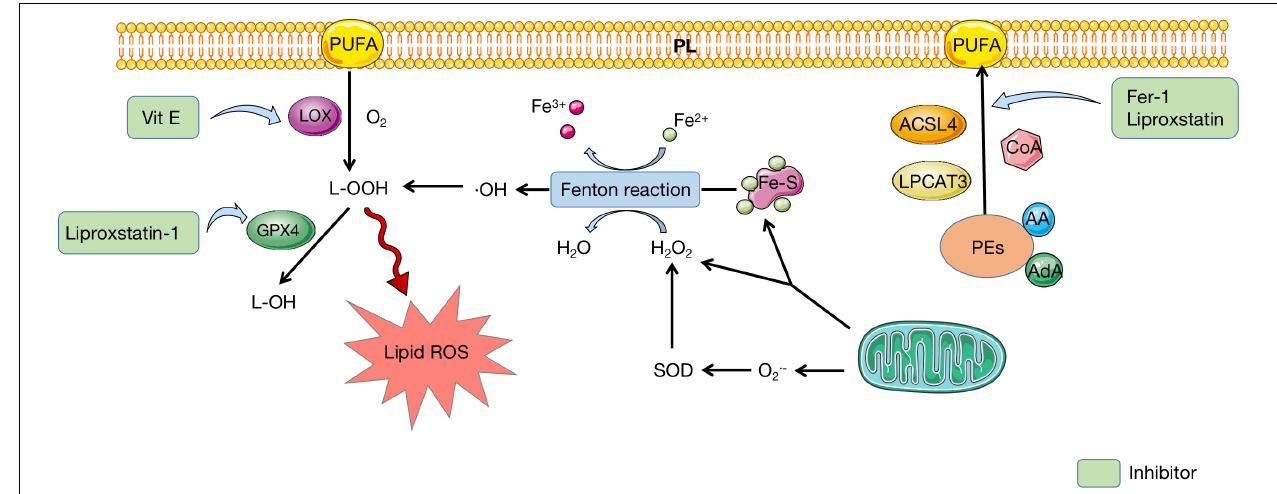
FIGURE 3 | Lipid metabolism in ferroptosis. PEs containing AA or AdA are fatty acid substrates, which are synthesized to PUFA under the catalysis of ACSL4, LPCAT3, and CoA. PUFA can insert to PL and be oxidated to produce L-OOH, which is catalyzed by LOX. Mitochondria provides Fe-S and H 2 O 2 to participate in Fenton reaction, during which iron is oxidated and H 2 O 2 is deoxidated. Reactive free radicals, · OH, is produced and eventually conversed into L-OOH, which leads to accumulation of lipid ROS. GPX4 can mediate the transformation of L-OOH to L-OH, which can be inhibited by liproxstatin-1. Fer-1 and liproxstatin are inhibitors of PUFA synthesis, while Vit E can inhibit LOX to prevent PUFA oxidation. PEs, phosphatidylethanolamines; AA, arachidonic acid; AdA, adrenic acid; PUFA polyunsaturated fatty acid; PL, polyunsaturated fatty acid; LOX, lipoxygenase; Fe-S, iron–sulfur cluster; SOD, superoxide dismutase; ROS, reactive oxygen species; GPX4, glutathione peroxidase 4; Fer-1, ferrostatin-1; Vit E, vitamin